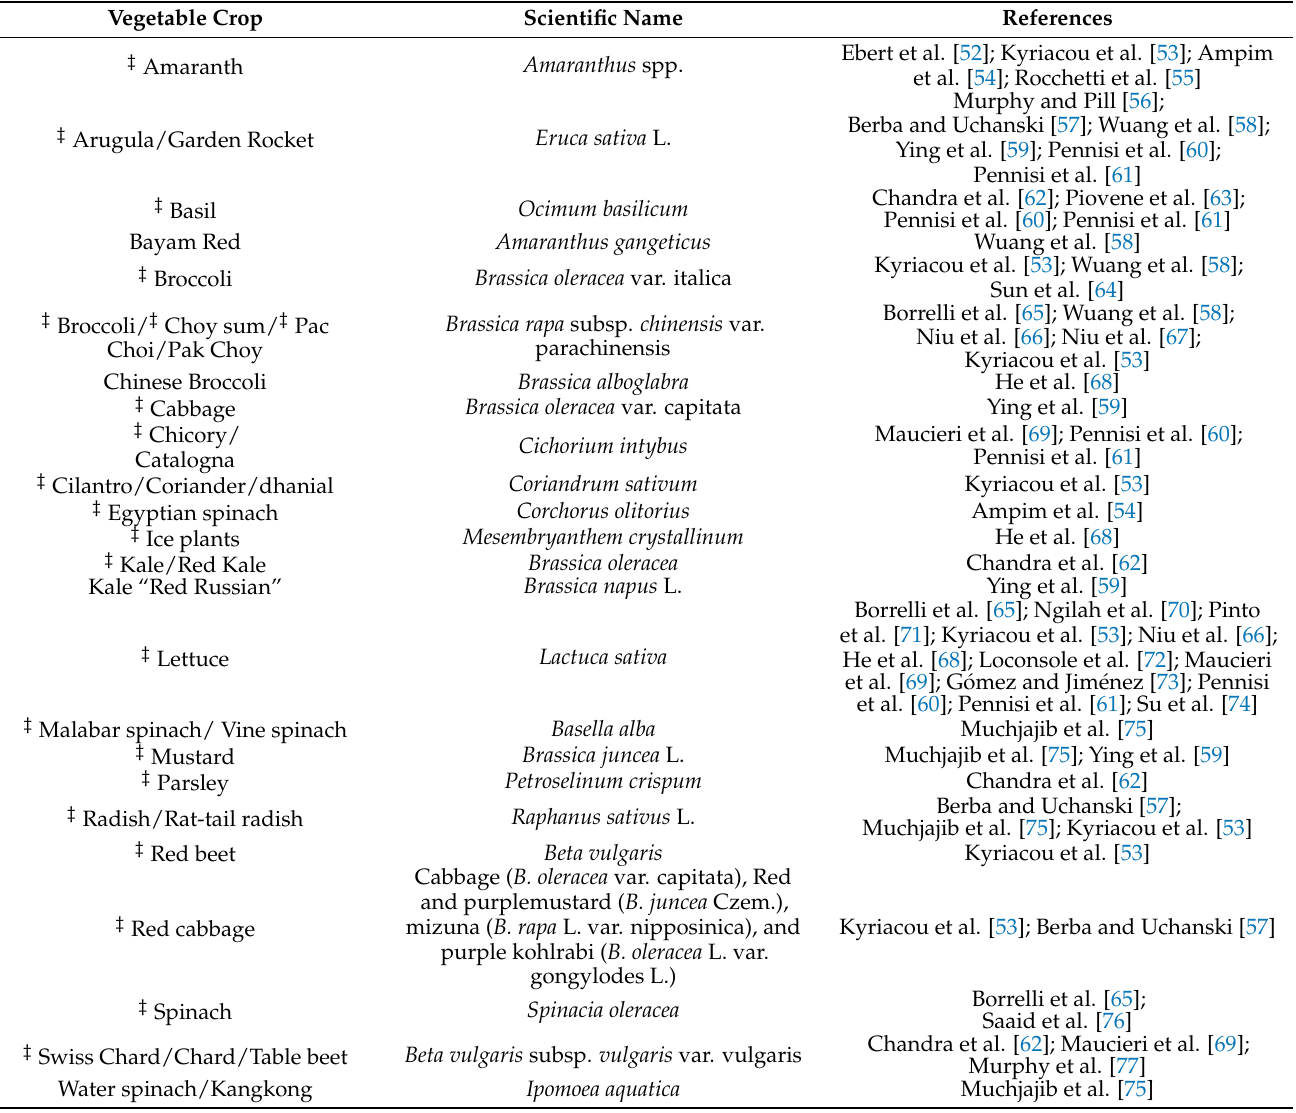
Table 1. List of some leafy vegetables and herbs studied for indoors production †